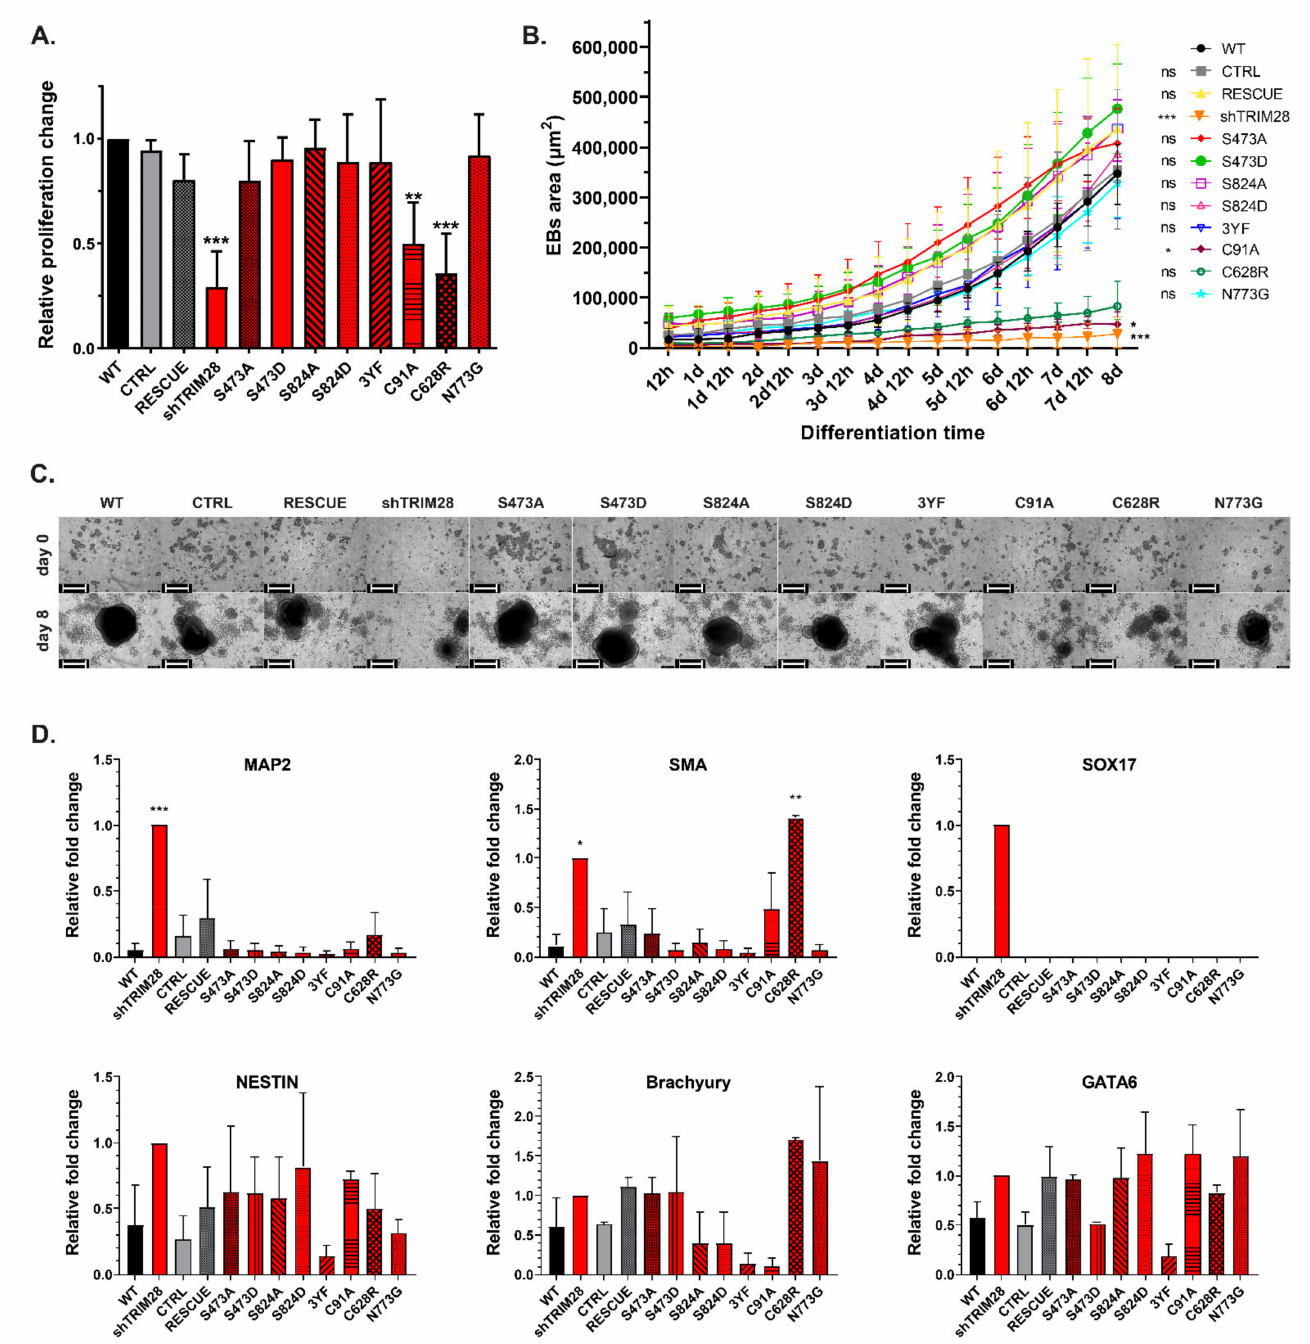
Figure 5. Dysfunction of RING and PHD domains results in decreased proliferation and inhibition of embryoid body formation. ( A ) Changes in iPSC proliferation calculated by spectrophotometry analysis of BrdU incorporation on the 6th passage after LV transduction ( n = 3). ( B ) EBs area was calculated from images taken by Incucyte for 8 days after induction of EBs formation. Each bar represents the mean area in µ m (SD), n = 3. Statistical analysis performed with Kruskal–Wallis test; p ≤ 0.05 (0.0001–0.001 ***; 0.001–0.01 **; 0.01–0.05 *; ≥ 0.05 not significant). ( C ) Example images taken by Incucyte during EBs formation ( n = 3). Scale bar: 400 µ m. See also Videos S1–S12. ( D ) QRT-PCR analysis of differentiation markers in iPSC populations 6 passages after LV transduction. Graphs represent markers related to ectoderm (Nestin, MAP2), mesoderm (SMA, Brachyury), endoderm (GATA6, SOX17). Each bar represents the mean mRNA expression level (SD), n = 3, SOX17: n = 1. If no amplification occurred, the expression level was calculated as 0. Statistical analysis performed with one-way ANOVA and a post-hoc Dunnett’s test; p ≤ 0.05 (0.0001–0.001 ***; 0.001–0.01 **; 0.01–0.05 *; ≥ 0.05 not